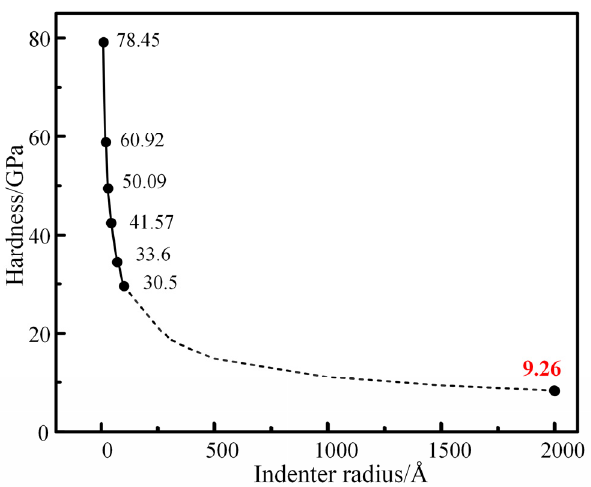
Figure 5. The fitting curves of matrix hardness values measured by nanoindentation simulation for diamond indenters with different radius sizes. It is predicted that when the radius of the diamond indenter is 200 nm, the hardness of the model measured is 9.26 GPa.